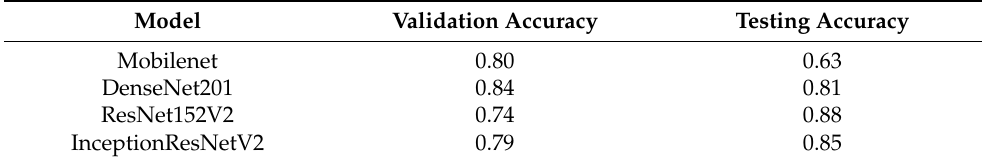
Table 3. Performance of the 4 best out of 40 pretrained networks for the binary classifier after 5 epochs.